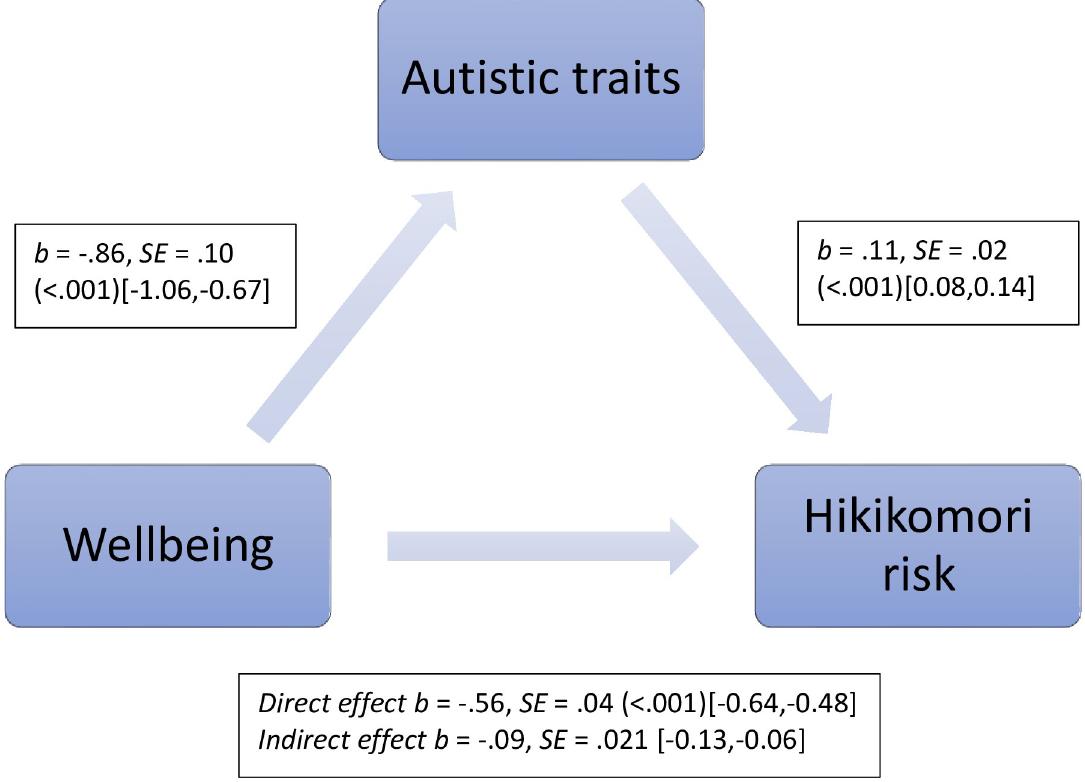
Fig 1. The indirect effect of autistic traits on the association between wellbeing and hikikomori risk. Regression coefficients are unstandardized. p values are shown in parentheses where applicable. 95% percentile bootstrap confidence intervals are shown in square brackets [5,000